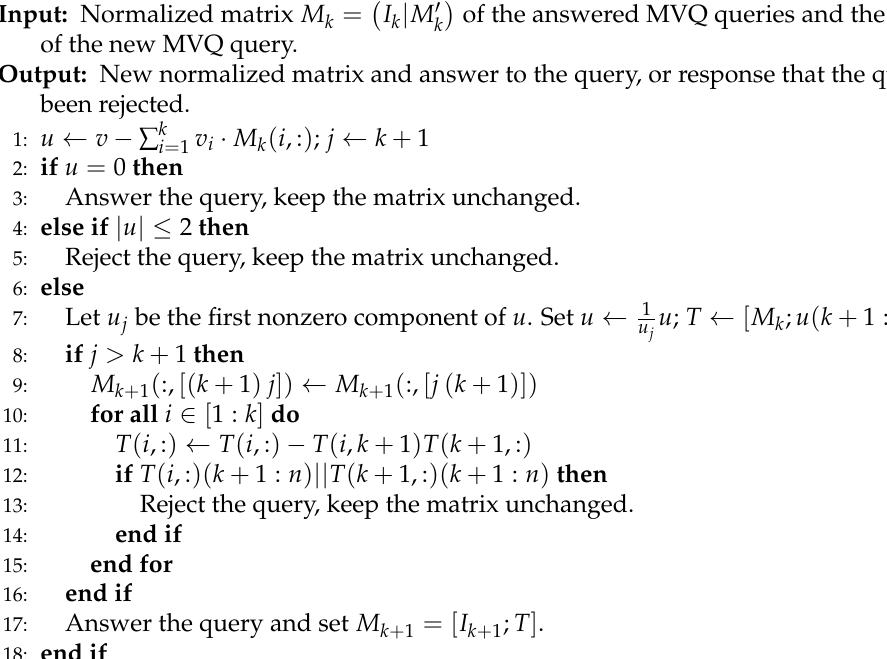
Algorithm 2 Quadratic Audit